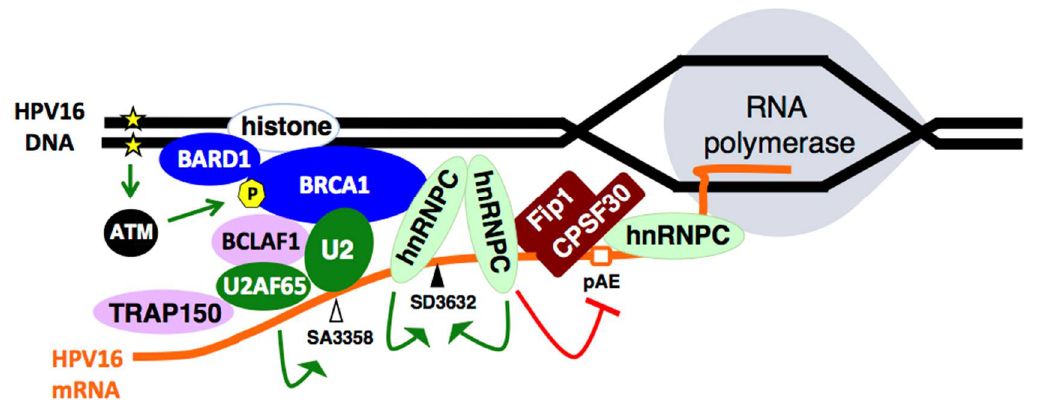
Figure 5. The DNA damage response activates HPV16 late gene expression by altering HPV16 mRNA splicing and polyadenylation. The DNA damage response induces ATM signalling. Activated ATM phosphorylates BRCA1, which leads to the formation of a pBRCA1-BCLAF1 complex that is recruited to the HPV DNA. The pBRCA1-BCLAF1 complex associates with splicing factors SF3b and U2AF65 and recruits them to the HPV16 DNA, thereby positioning the spliceosome in a strategic position for efficient detection of nascent HPV16 mRNA. hnRNP C is also recruited to both HPV16 DNA and mRNA through interactions with phosphorylated BRCA1. hnRNP C binds to the HPV16 early untranslated region and inhibits the HPV16 early polyadenylation signal pAE, possibly through interactions with Fip1 and CPSF30. This inhibition causes read-through at the early polyadenylation signal (pAE) and activates HPV16 late gene expression. hnRNP C also regulates HPV16 alternative splicing by activating late L1 splice site SD3632, contributing to the production of splices late L1 mRNAs. When the DNA damage response is activated, levels of the splicing regulatory protein TRAP150 increased in affected cells. The DNA damage response promotes the association of TRAP150 HPV16 DNA as well as with general splicing factor U2A65, thereby recruiting U2AF65 to HPV16 and contributing to the enhanced association of U2AF65 with HPV16 mRNAs. Taken together, the DNA damage response-induced associations of DNA damage response factors with RNA processing factors and with the HPV16 DNA and mRNAs alters HPV16 splicing and polyadenylation to induce HPV16 late gene expression.